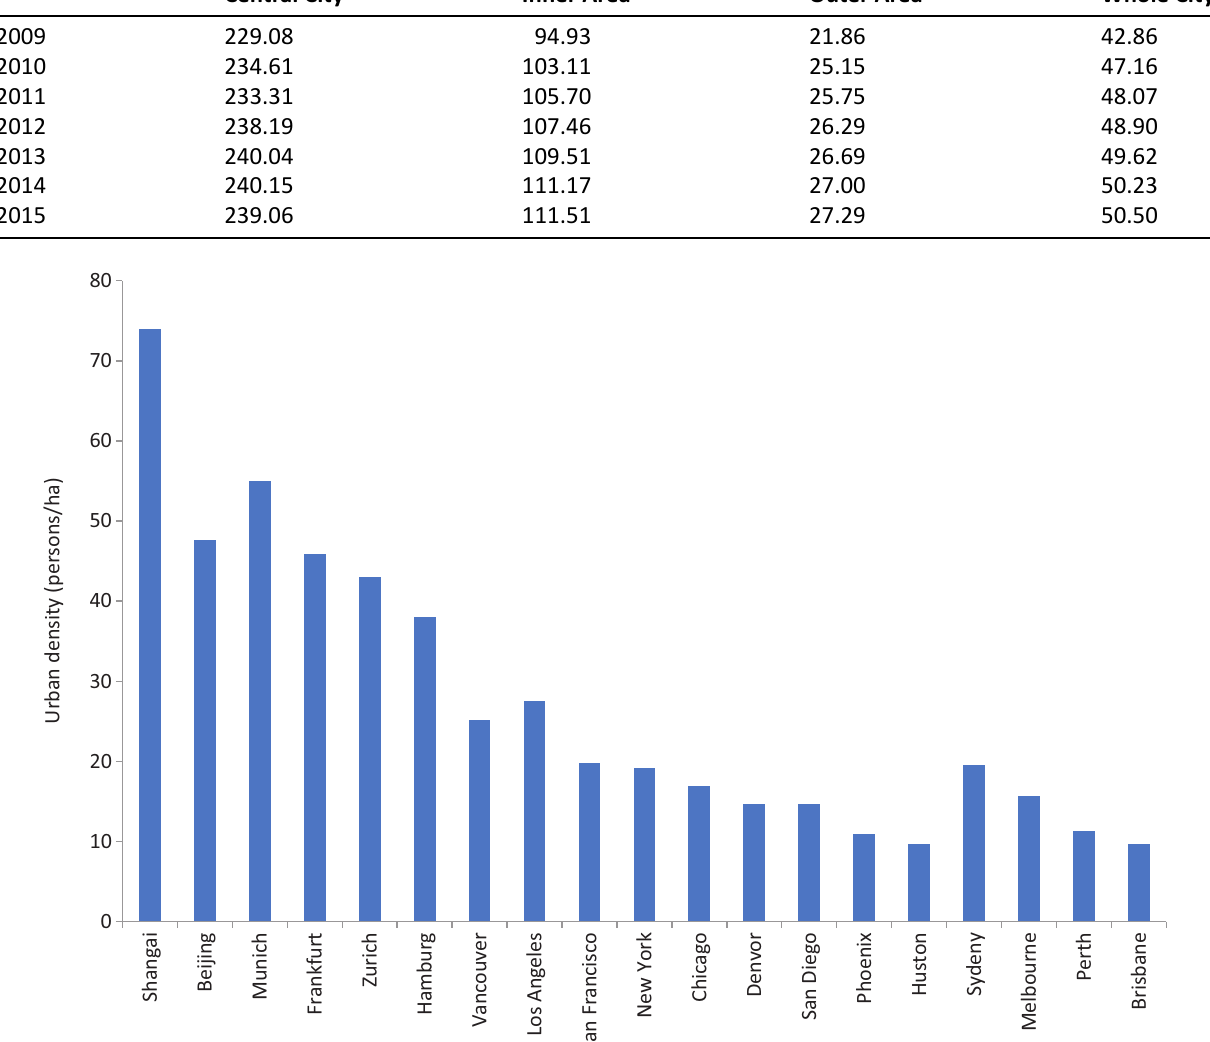
Figure 8. Comparisons of urban densities between Beijing and other cities in the developed world in 2005. Source: Com- piled based on data provided by the Beijing Municipal Bureau of Statistics (BJMBS, 1982–2015, 2016) and Newman and Kenworthy